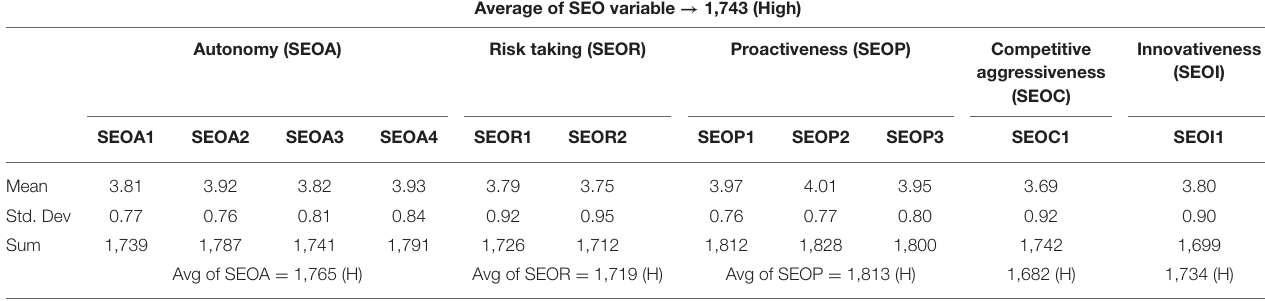
TABLE 6 | Descriptive analysis of SEO perception.